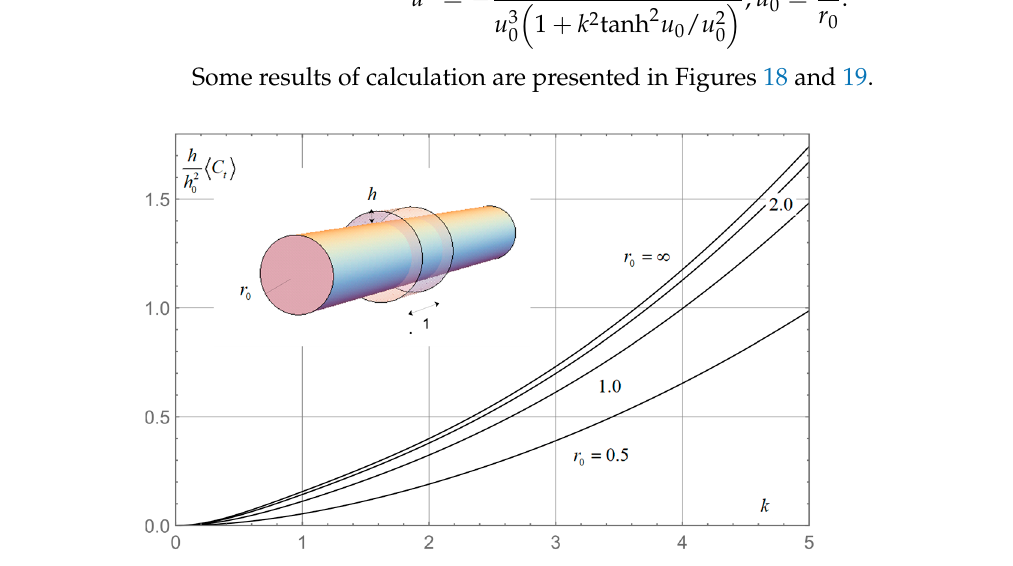
Figure 18. Period-averaged thrust force coefficient versus Strouhal number for a ring-wing heaving with respect to circular cylinder in extreme ground effect for different ratios of the cylinder radius to the chord.